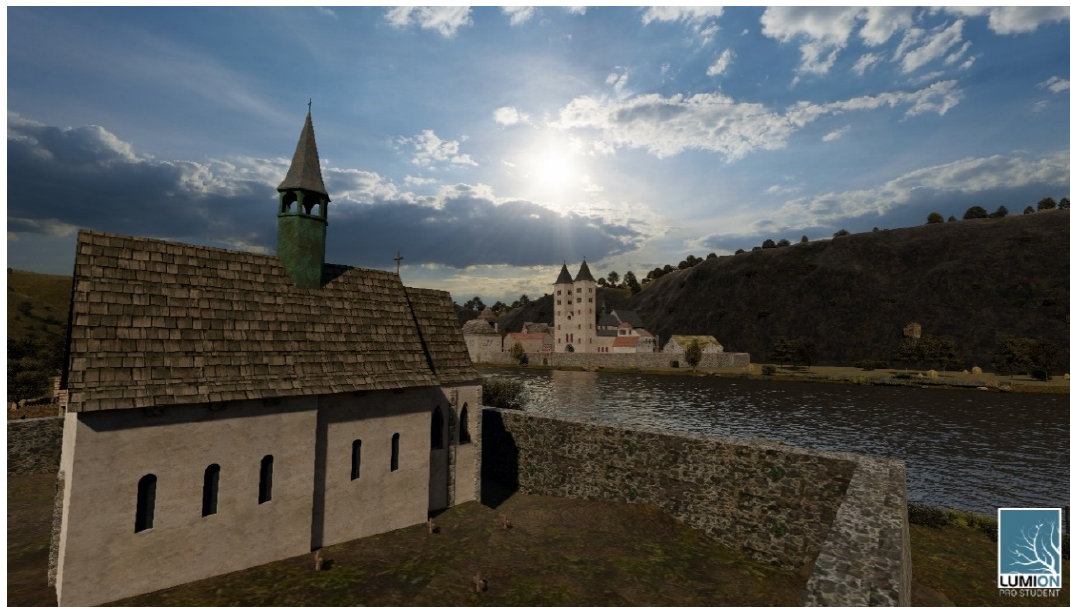
Figure A5. Visualization of Church of St. Kilián and the monastery in the Gothic era.